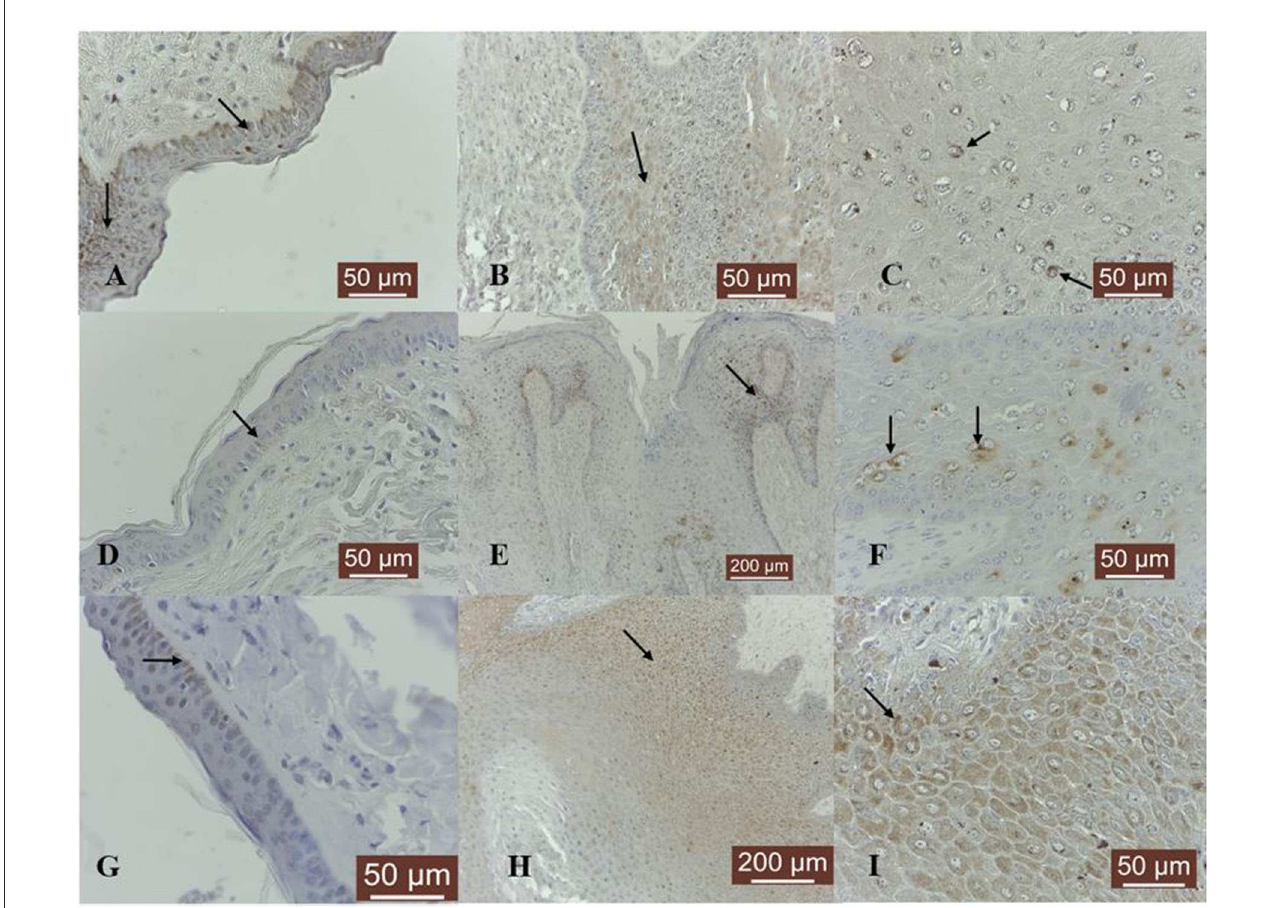
FIGURE1 MMP-1/-8/-13 immunostaining in bovine normal skin and fibropapillomas: (A) In bovine normal skin, a moderate immunoreactivity for MMP-1 is noted in the cytoplasm of epithelial cells (black arrows); 40 X. (B) In bovine fibropapillomas MMP-1 is expressed as a weak cytoplasmic (black arrow) and perinuclear pattern both in epithelial and fibroblast cells; 20 X. (C) MMP-1 in fibropapilloma: note the fine granular perinuclear positivity of upper epithelial cells (black arrow); 40 X. (D) In normal skin samples, MMP-8 showed a specific weak immunoreactivity in a cytoplasmic (black arrow) pattern in all epithelial cells; 40 X. (E) In fibropapillomas, MMP-8 was strongly expressed in epithelial cells, while the fibroblasts showed a weak reactivity; 20 X. (F) Note a detailed fine strong granular cytoplasmic and perinuclear (black arrow) pattern in scattered epithelial cells from spinosum layer; 40 X. (G) Normal skin: MMP-13 weak cytoplasmic immunoreactivity (black arrow) predominantly in basal cell layer; 40 X. (H) Fibropapillomas: MMP-13 appeared as a finely granular cytoplasmatic staining in epithelial cells (black arrow); 20 X. (I) A detailed MMP-13 moderate cytoplasmic (black arrow) immunosignaling confined to all epithelial cells; 40 X. Streptavidin-biotin-peroxidase